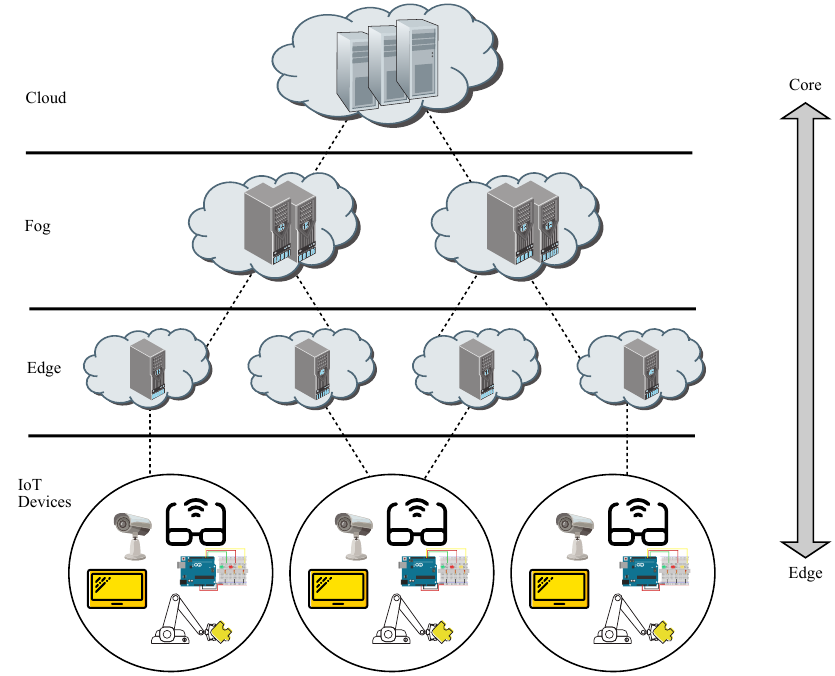
Figure 5. Block diagram for fog